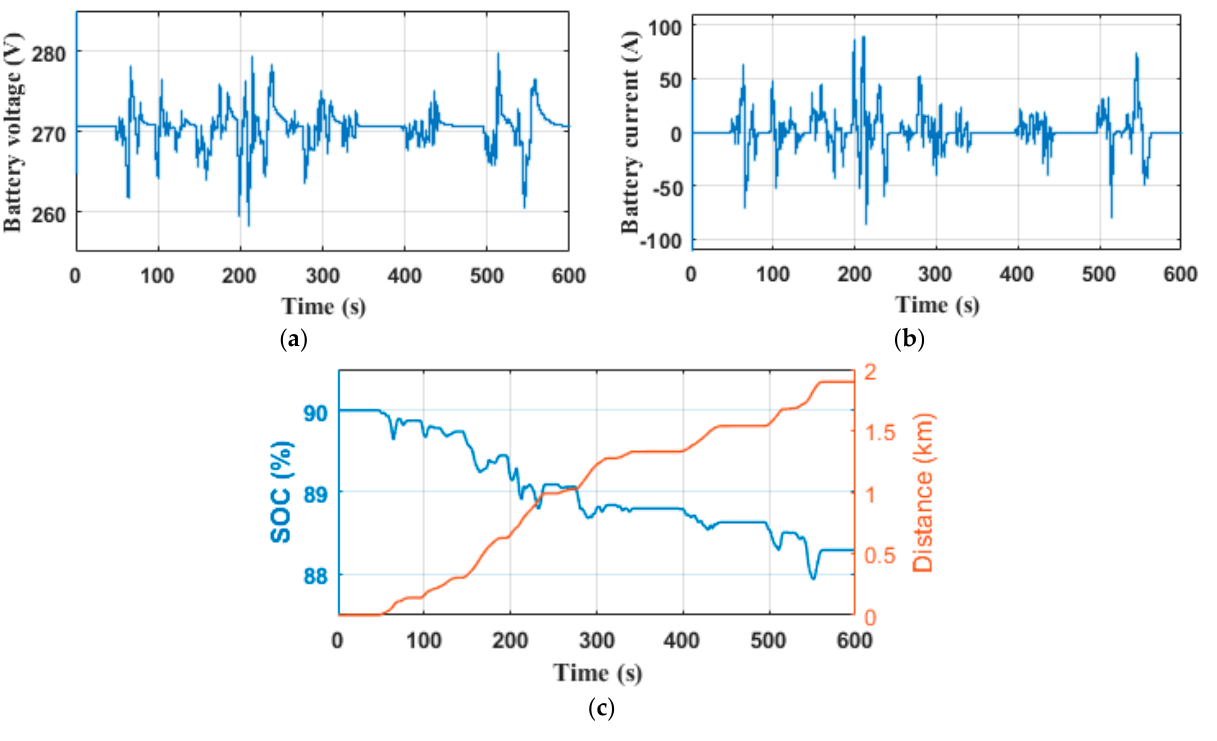
Figure 23. Li-ion battery performance with MPDTC technique ( a ) voltage; ( b ) current; ( c ) state of charge and covered distance.